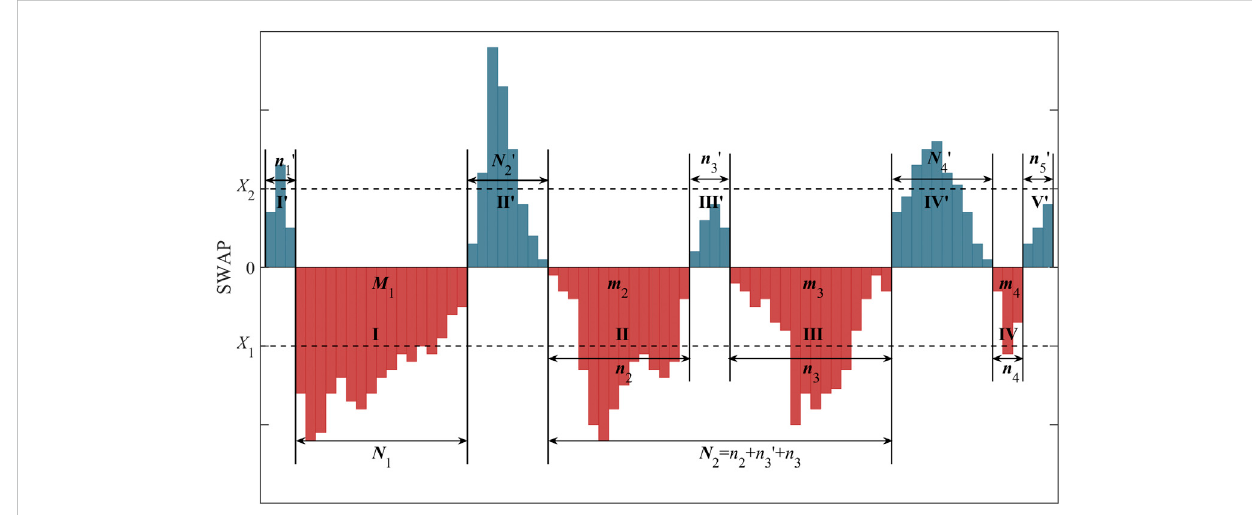
FIGURE 2 Illustration outlining the identi fi cation of drought or fl ood events based on the SWAP index and the theory of